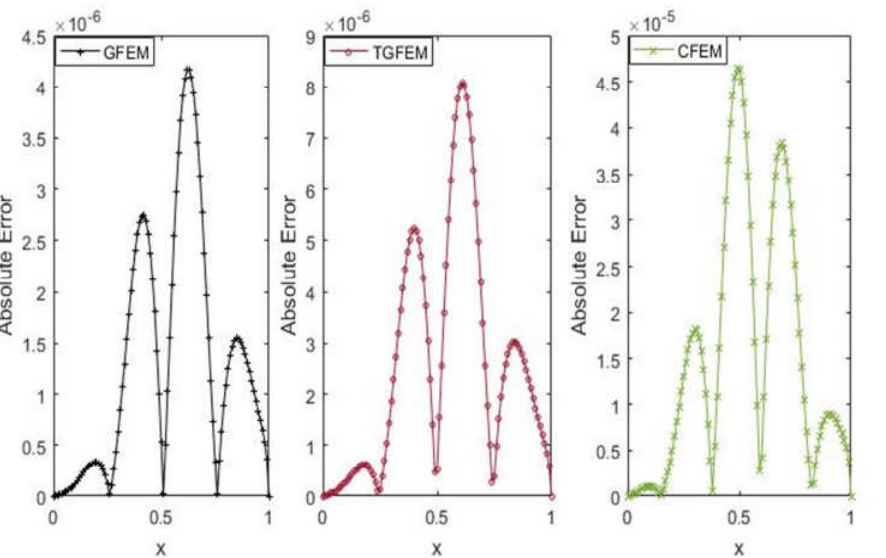
Figure 6 . Absolute errors of the suggested methods at with the parameters (cid:14) (cid:2) 1,(cid:10) (cid:2) 0.01,(cid:13)(cid:14) (cid:2) 0.001 , (cid:16)(cid:17) (cid:2) 0.1 and (cid:18)(cid:19) (cid:2) 1 in Problem 3